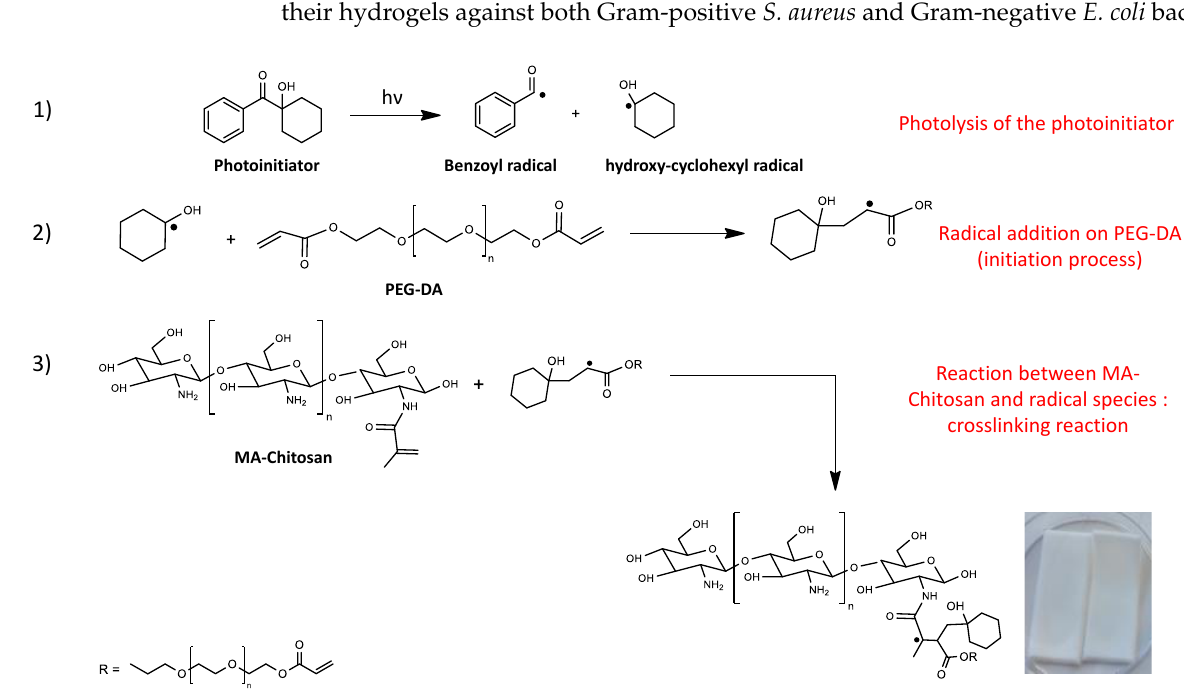
Figure 6. Schematic representation of the free-radical photoinduced crosslinking between poly(ethylene glycol) dimethacrylate (PEG-DA) and methacrylated chitosan (MA-Chitosan) and optical image of the resulting hydrogel. ( 1 ) Photolysis of 1-hydroxy-cyclohexyl-phenyl-ketone, ( 2 ) radical addition on PEG-DA (initiation process) and ( 3 ) Reaction between MA-Chitosan and radical species (crosslinking reaction) Reprinted with permission. Copyright 2019, Royal Society of Chemistry [62].